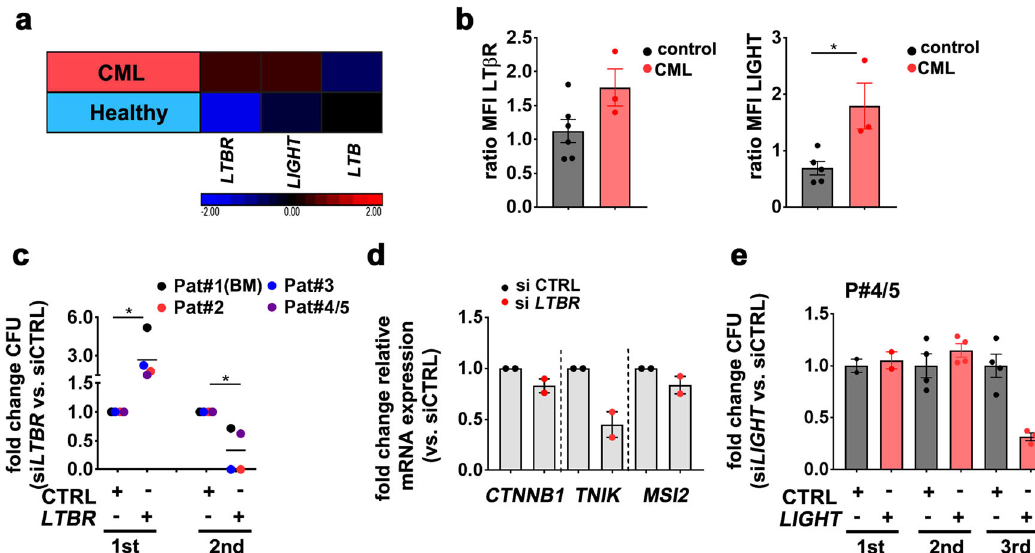
Fig. 8 LT β R signaling in CD34 + HSPCs from CML patients. a Heatmap analysis for LTBR , LIGHT , and LTB gene expression (log 2 fold differences) in PB CD34 + Lin − cells from CML patients (red) and healthy donors (blue) of a publicly available dataset (GEO: GSE11675). b MFI of LT β R and LIGHT in BM HSPCs (black, n = 6) and BM HSPCs from CML patients (red, n = 3). Data are pooled for analysis from fi ve independent experiments. c Fold change CFU and re-plating of CML HSPCs, transfected with si LTBR vs. siCTRL ( n = 4, one sample (Pat 4/5) was used as pooled cells from two CML patients. Data are pooled for analysis from two independent experiments and shown as grand mean. d Fold change of mRNA expression of indicated genes in si LTBR (red)- transfected CML HSPCs, relative to siCTRL (black)-treated CML HSPCs ( n = 4, data are pooled for analysis from two independent experiments. e Fold- change CFU and re-platings of si LIGHT (red)-transfected CML HSPCs, relative to siCTRL (black). Cells were pooled from n = 2 CML patients. Data are presented as mean ± SEM. Statistics: * P < 0.05 (two-tailed t test: b , c ). b : LT β R, p = 0.07, LIGHT, p = 0.030; c : 1st, p = 0.018, 2nd, p =